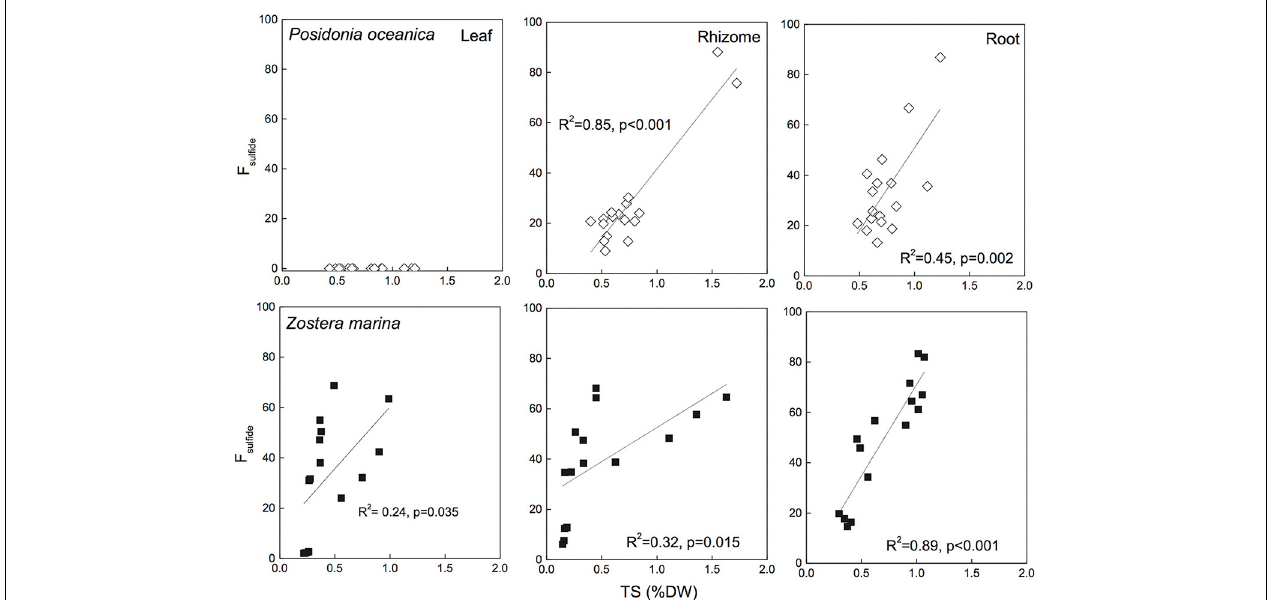
FIGURE 6 | Correlations between seagrass tissue total sulfur content (Tissue TS) and F sulfide (fraction of tissue sulfur derived from sulfide) Posidonia oceanica (upper panel) and Zostera marina (lower panel) and leaves (left row), rhizomes (middle row), and roots (right row). The